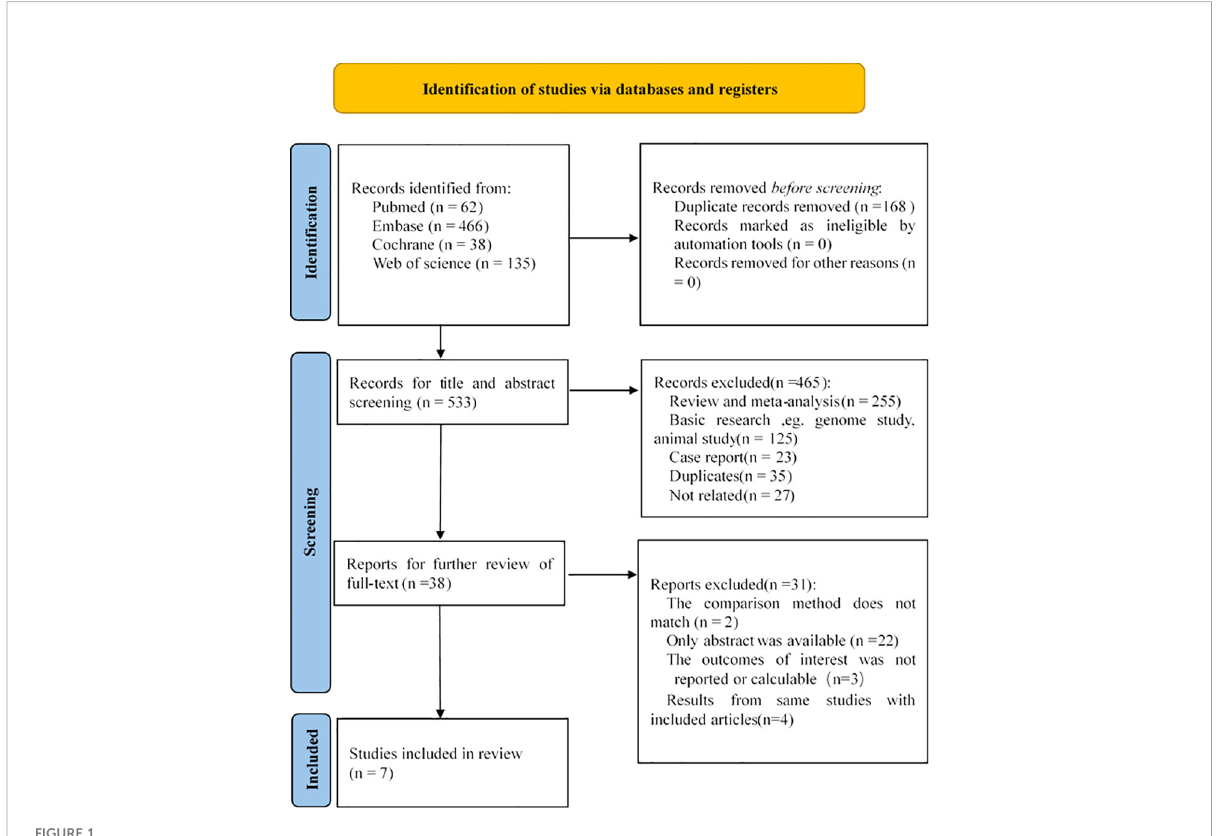
FIGURE 1 Flow chart of studies selection